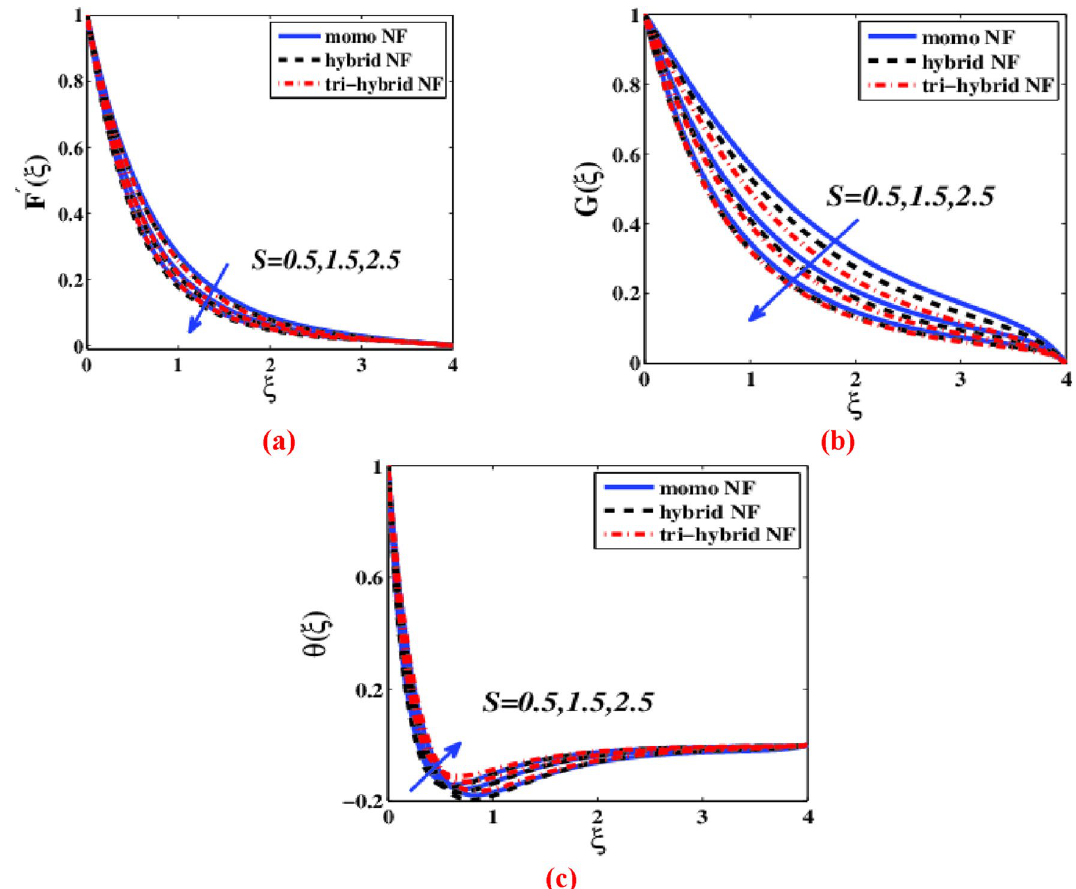
Figure 8. ( a ) F ′ (ξ) , ( b ) G (ξ) and ( c ) θ(ξ) with diverse S